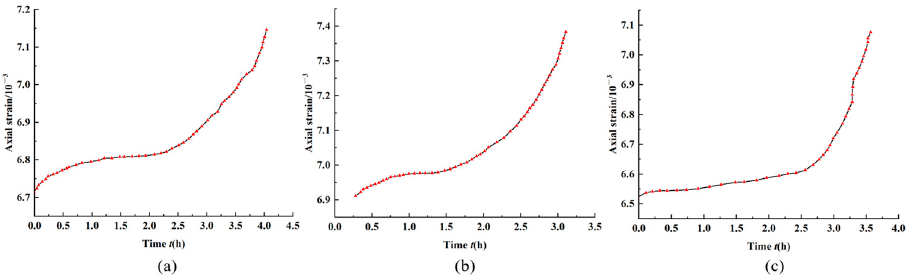
Figure 13. The curve of the accelerated creep stage of specimens with different porosity. ( a ) The porosity interval is 5~10%; ( b ) the porosity interval is 10~15%; ( c ) the porosity interval is 15~20%.